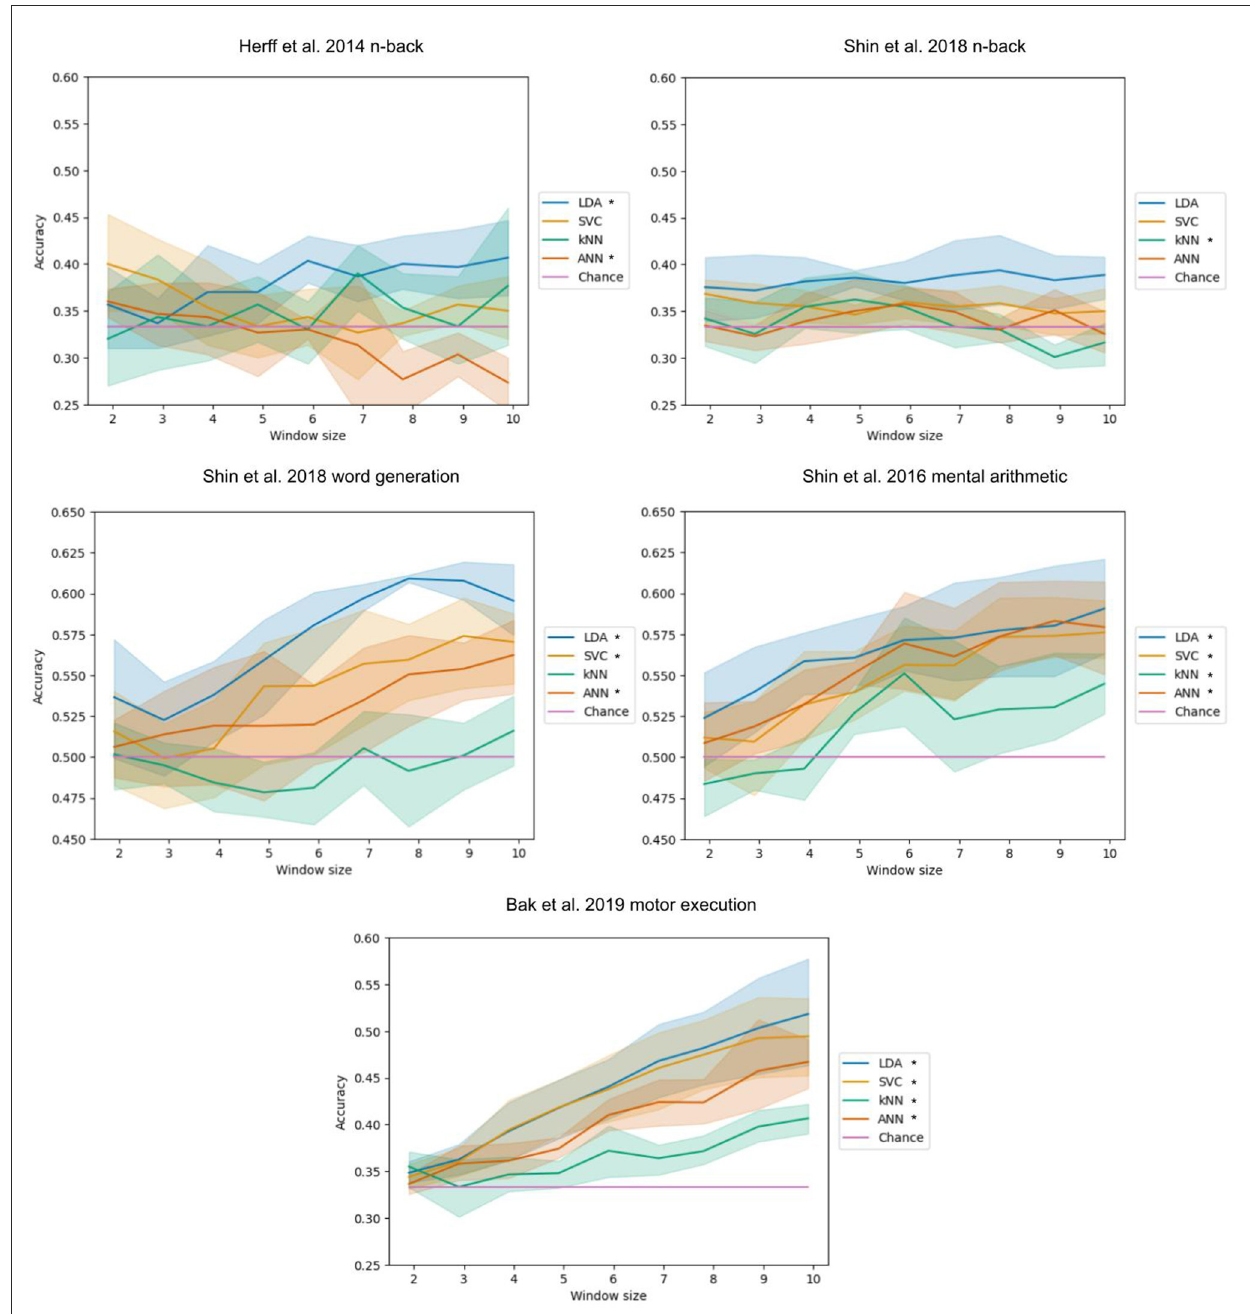
FIGURE2 Accuracy with respect to the time window length. The bands represent the 95% confidence interval related to the variability on the five-fold outer cross-validation. Legend entries marked with an asterisk indicate a significant correlation at a 5% threshold.